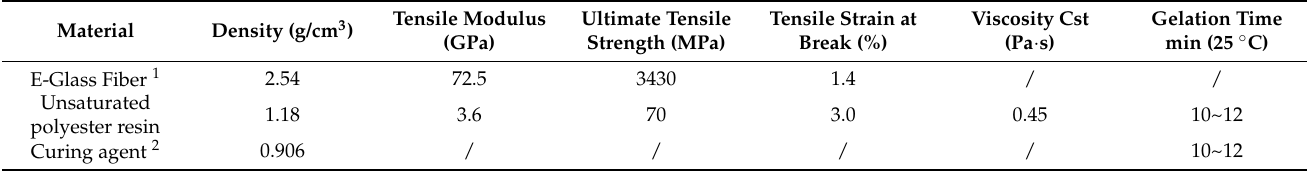
Table 1. Mechanical properties of E-Glass Fiber and unsaturated polyester resin.